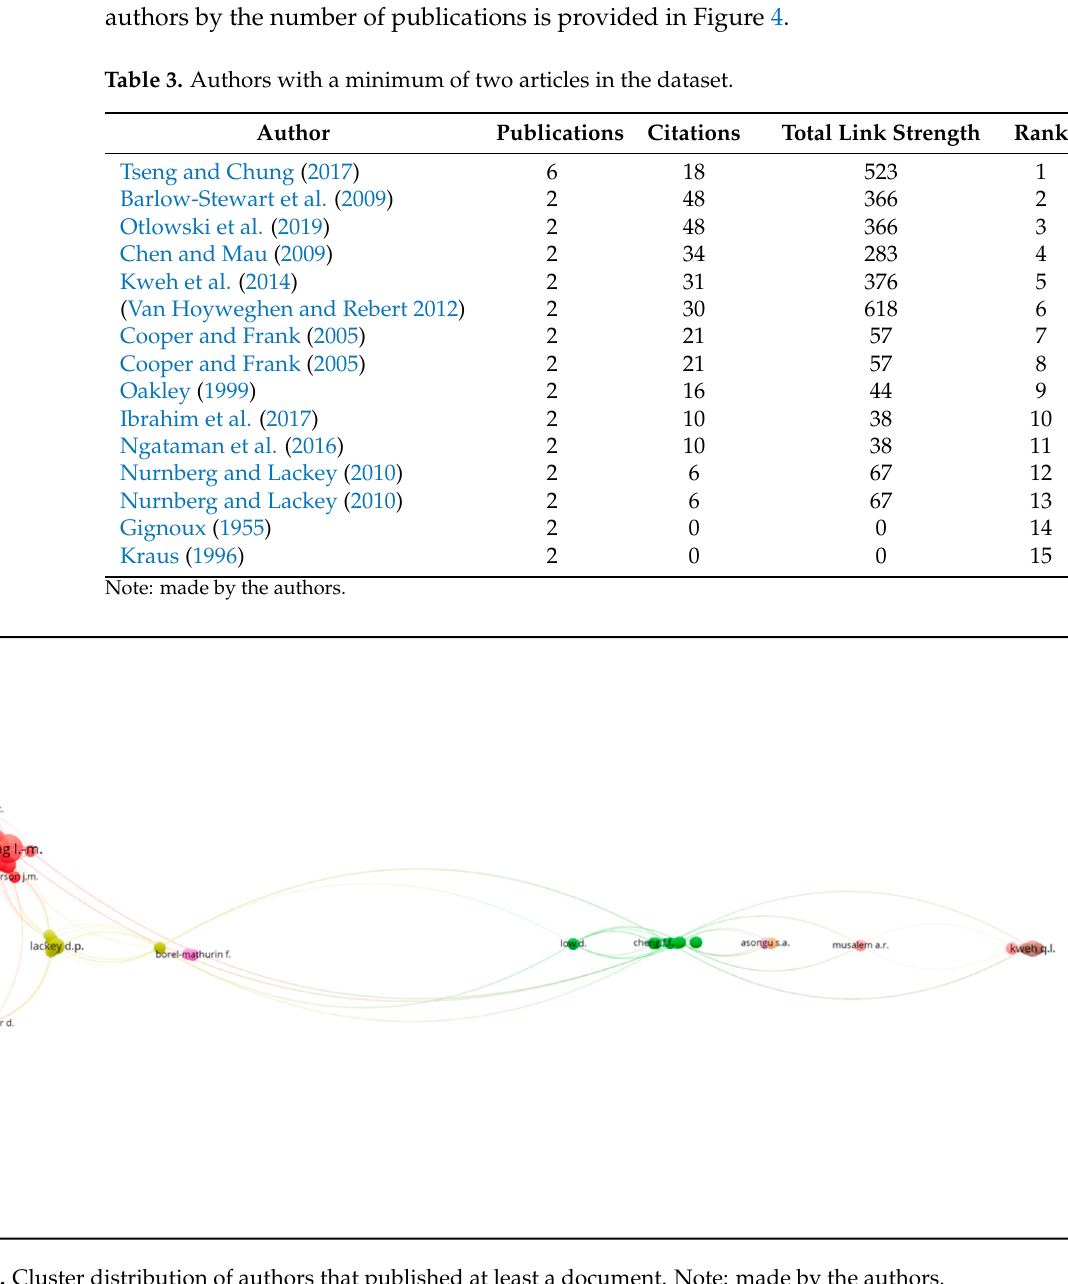
Figure 4. Cluster distribution of authors that published at least a document. Note: made by the authors.